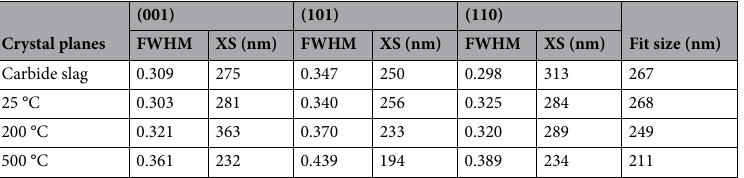
Table 2. Fitting results for crystallite size of Ca(OH) 2 in 3:7 particles with 10 wt% Na 2 CO 3 . FWHM full width at half maximum, XS crystallite size.